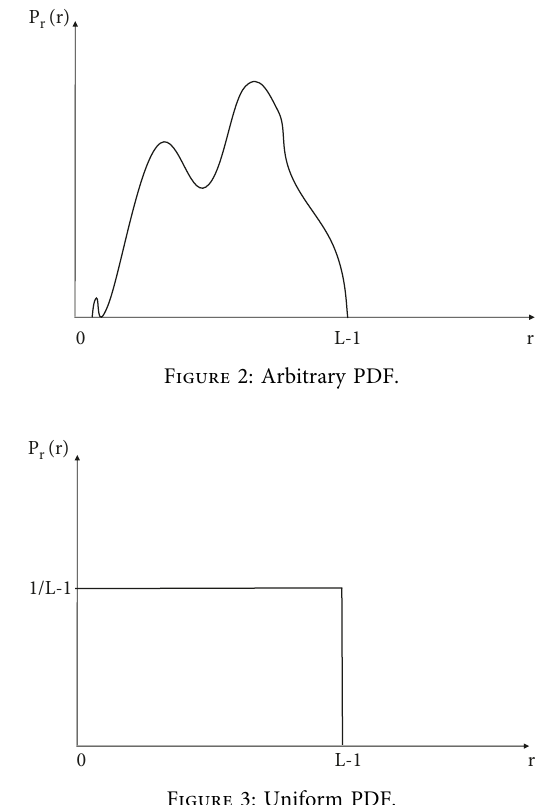
Figure 3: Uniform